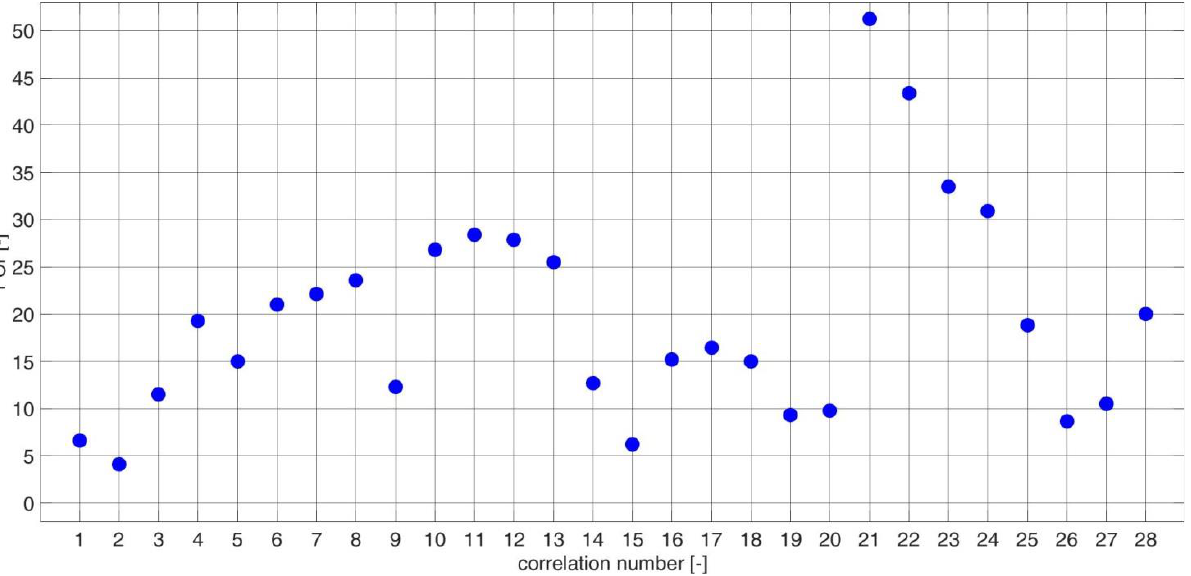
Figure 5. The Fisher criteria, provided by CCSM3, for each correlation number (Table A1).